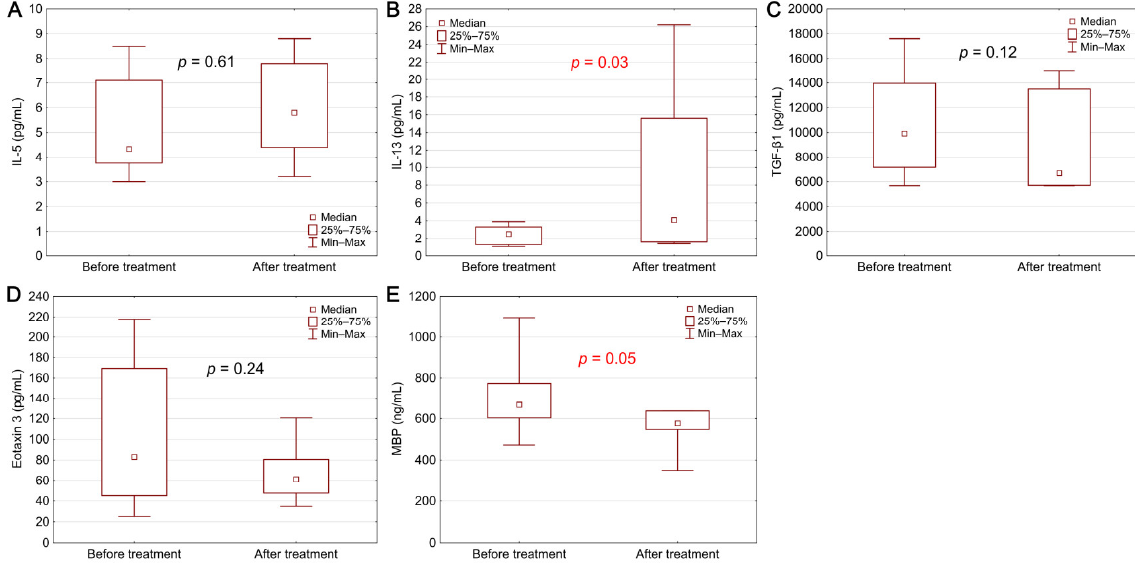
Figure 2. Biomarker levels in EoE patients before and after treatment: ( A ) IL-5, ( B ) IL-13, ( C ) TGF- β 1, ( D ) eotaxin 3, ( E ) MBP. Statistical significance was evaluated with a Wilcoxon test.